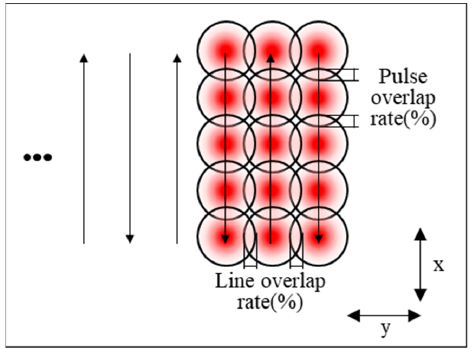
Figure 4. Schematic of the experimental approach based on the laser beam overlap